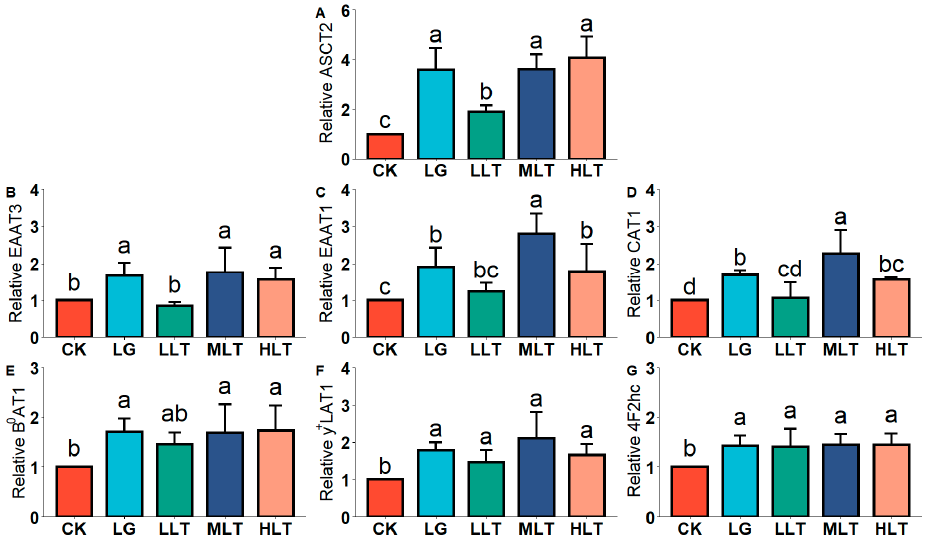
Figure 1. Effects of L-theanine on mRNA expression of amino acid transporters of ( A ) ASCT2, ( B ) EAAT3, ( C ) EAAT1, ( D ) CAT1, ( E ) B 0 AT1, ( F ) y + LAT1, and ( G ) 4F2hc in the duodenum of mice. CK (control), HLT (LTA—400 mg • kg − 1 • d − 1 ), MLT (LTA—300 mg • kg − 1 • d − 1 ), LLT (LTA—100 mg • kg − 1 • d − 1 ), and LG (L-glutamine—300 mg • kg − 1 • d − 1 ) groups. Values are presented as mean ± SD; n = 10/group. Different superscript letters in the same figure indicate statistically significant differences ( p < 0.05).